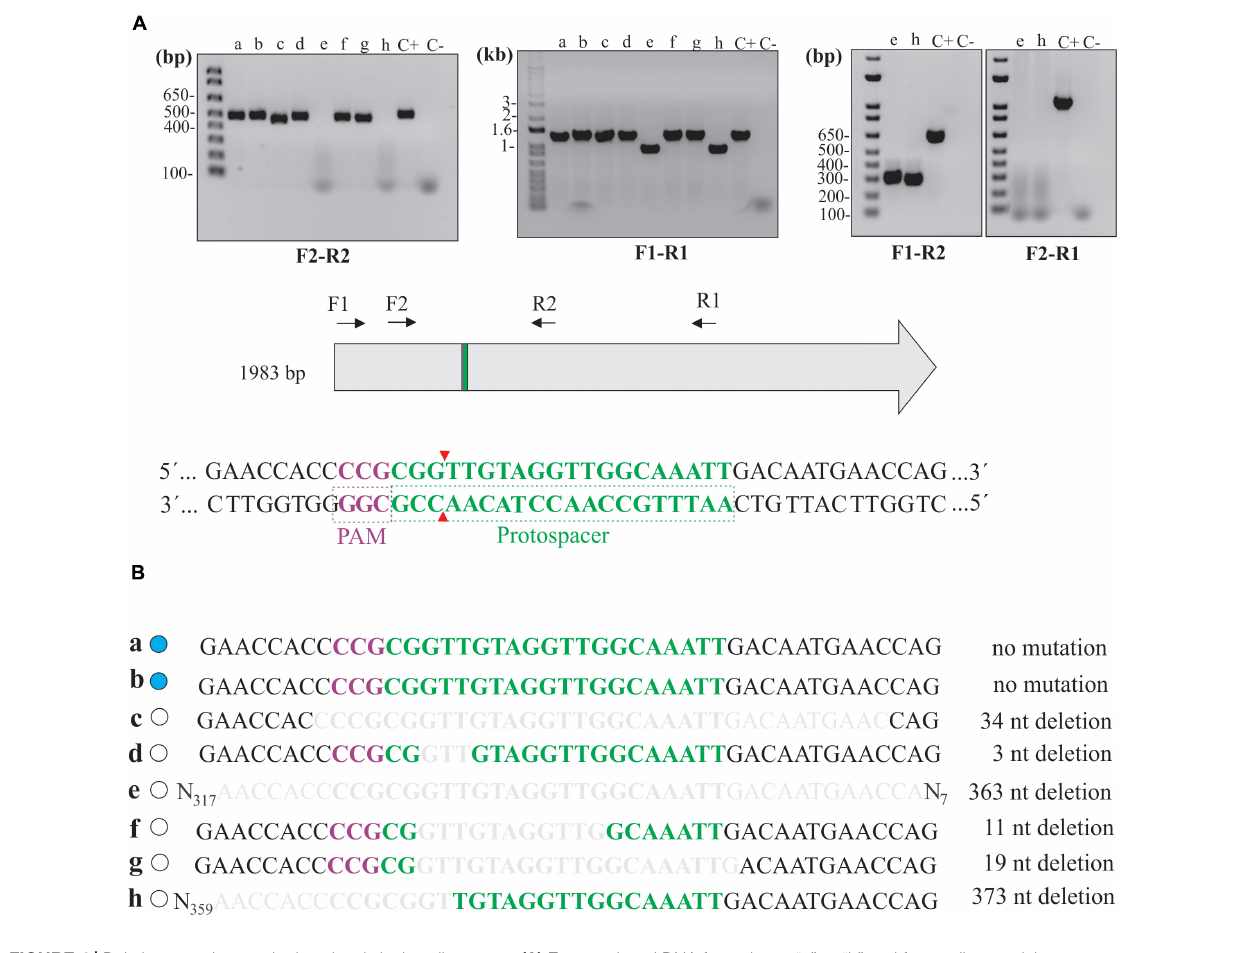
FIGURE 4 | Deletion mutations at the junctional site in null mutants. (A) Extracted total DNA from clones “a” to “h” and from cells containing pMaOriCas9NHEJtuberculosis (C +) was amplified by PCR using a diverse array of primers, as depicted in the scheme showing the coding sequence of β -galactosidase, as well as protospacer, PAM NGG, and Cas9 cleavage site. A negative control (C-) without a template was also included. (B) Amplicons were sequenced with primer combinations that resulted in positive amplification and were compared to the WT sequence. β -Galactosidase status of each clone is shown on the left side (blue, WT; white, mutant) and deletion size is shown on the